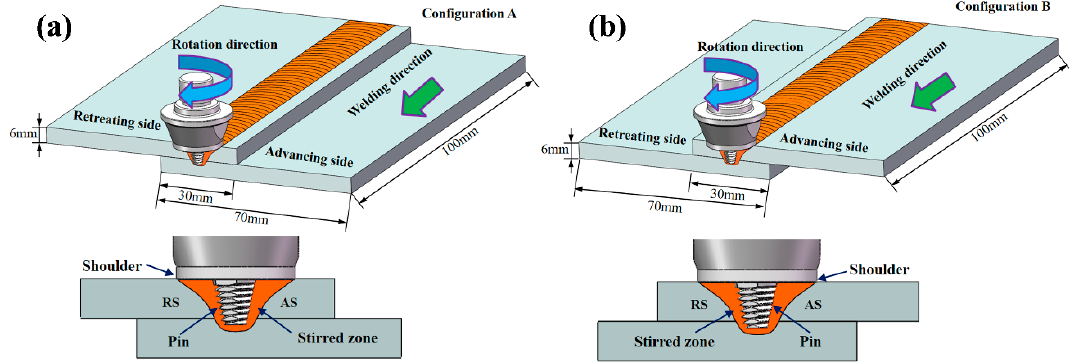
Figure 2. Schematic of lap joints in ( a ) configuration A and ( b ) configuration B.